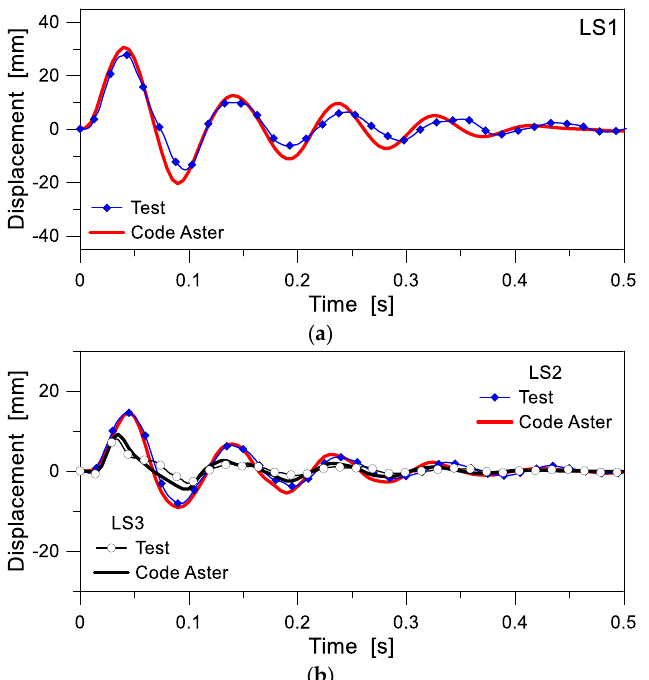
Figure 15. Numerical and experimental out-of-plane displacements for the curtain wall under SB (P#1, E imp = 900 J). In evidence, the control points ( a ) LS1 and ( b ) LS2, LS3.